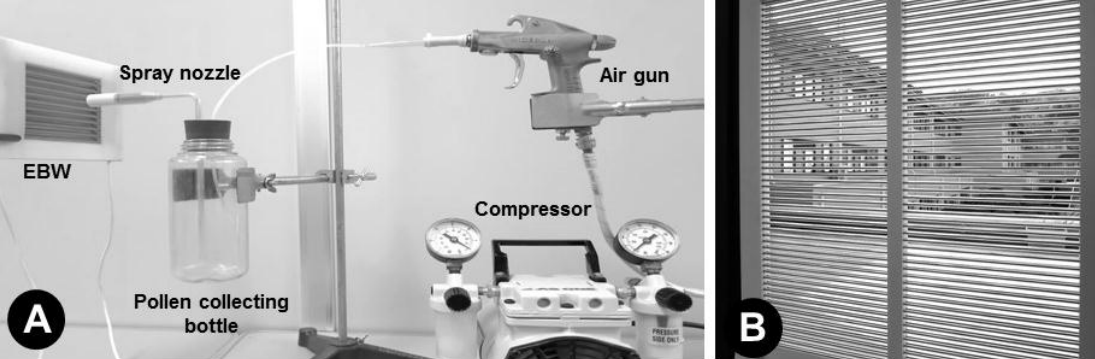
Figure 2. Test-size EBW used for the pollen-blowing test ( A ) and window-size EBW installed on a laboratory window ( B ). Table 1. Percentage of Japanese cedar pollens captured by the ICWs of the electrostatic barrier forming window (EBW) and adhesive plate placed on the opposite side of the